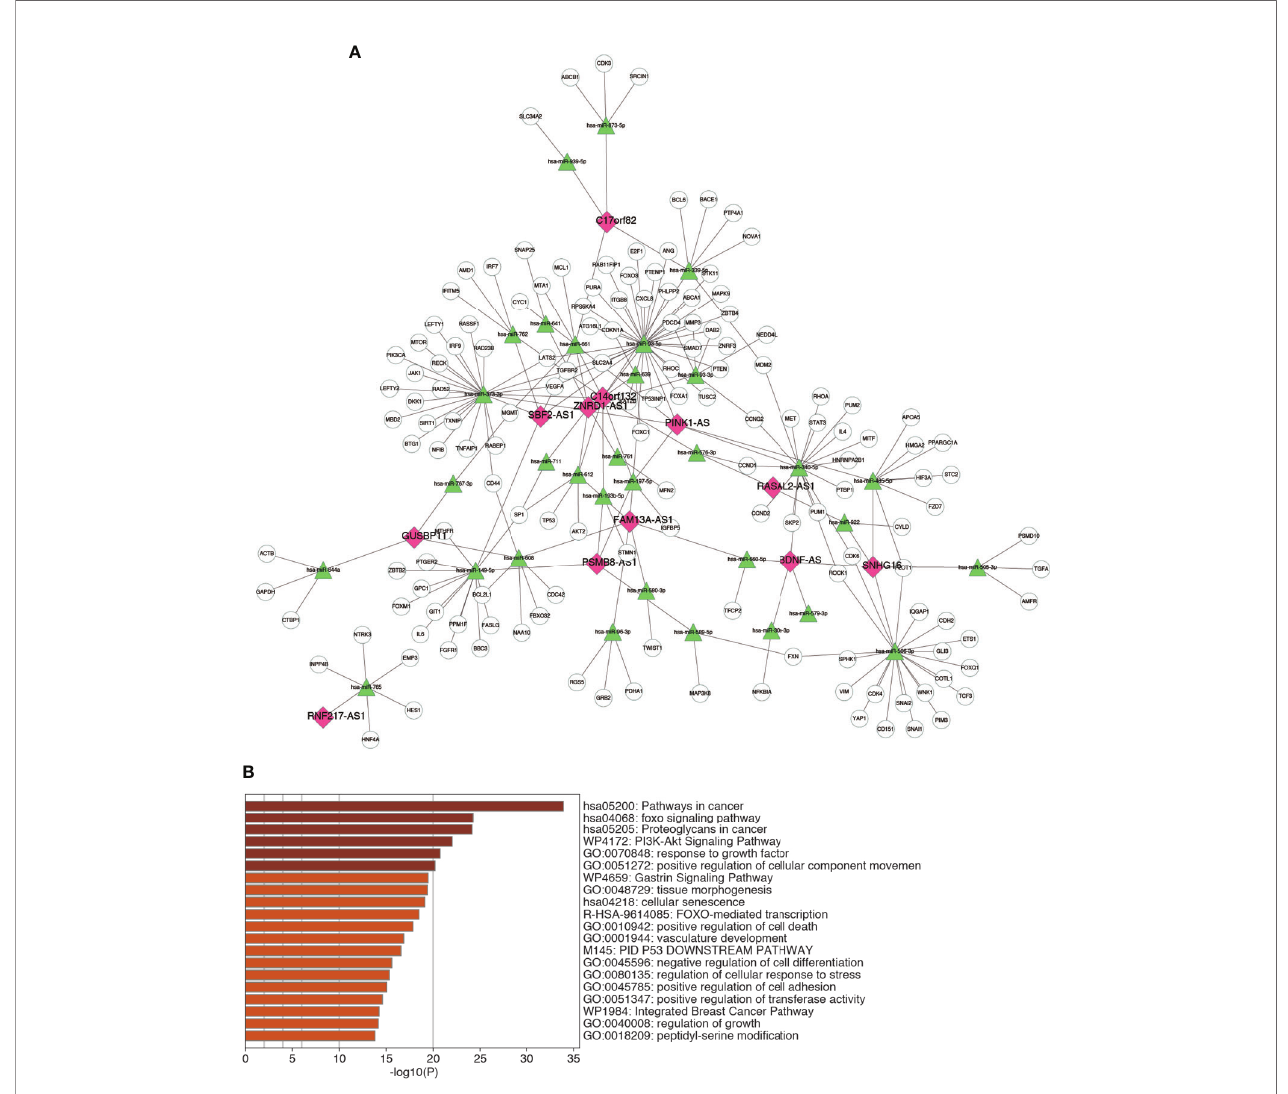
FIGURE 7 | Construction of ceRNA network. (A) The ceRNA network of the 12 m6A-related lncRNAs and their target miRNAs and mRNAs. (B) Top 20 enriched terms across the 148 target